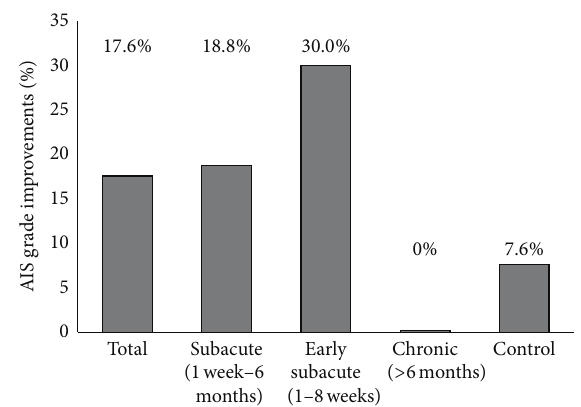
Figure 2: Percentage of individuals converting from sensorimotor complete (AIS-A) to incomplete cervical SCI (AIS-B or AIS-C) in the transplantation and control